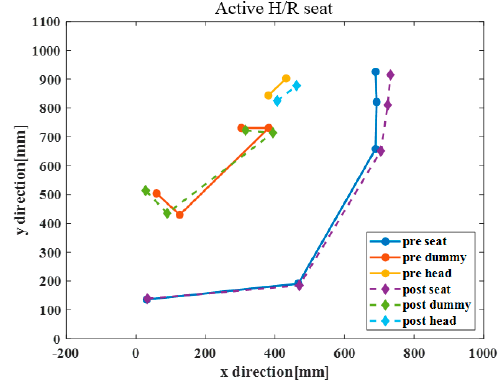
Figure 6. Results for the active headrest before and after the sled test.